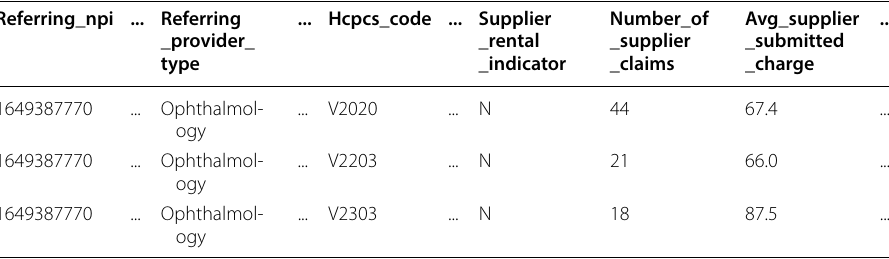
Table 3 Sample of